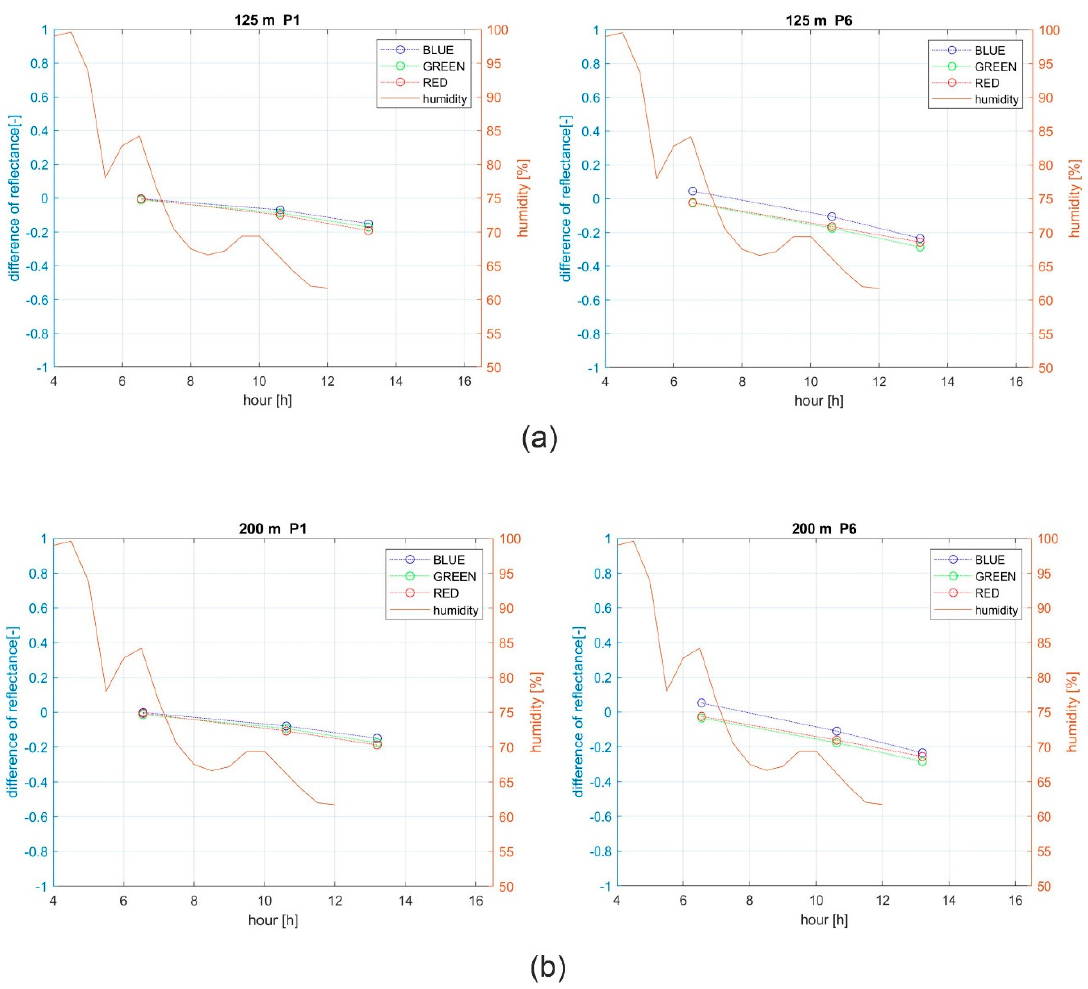
Figure 17. Air humidity and residuals from the theoretical value of reflectance for 2 and 95% tests for data obtained at ( a ) 125 m and ( b ) 200 m in good weather conditions (Mieruniszki area, September 13, 2018).